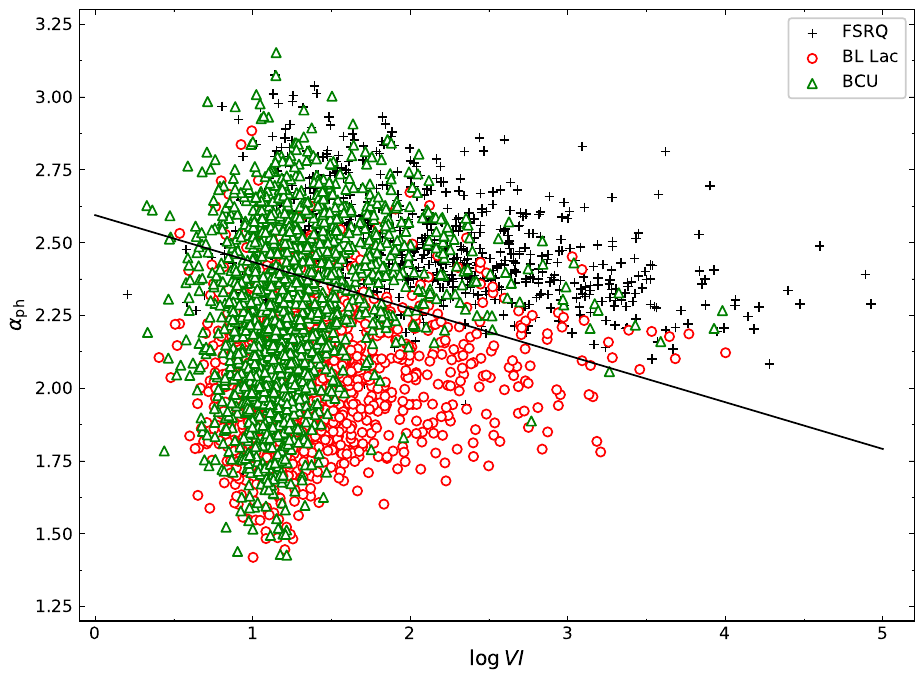
Figure 4. Plot of variability index (log VI ) against gamma-ray photon flux (log F ). Open circles stand for BL Lacs, plus for FSRQs and triangle points for BCUs. The solid line ( α ph = − 0.161log VI + 2.594) is obtained from the SVM method; it separates FSRQs and BL